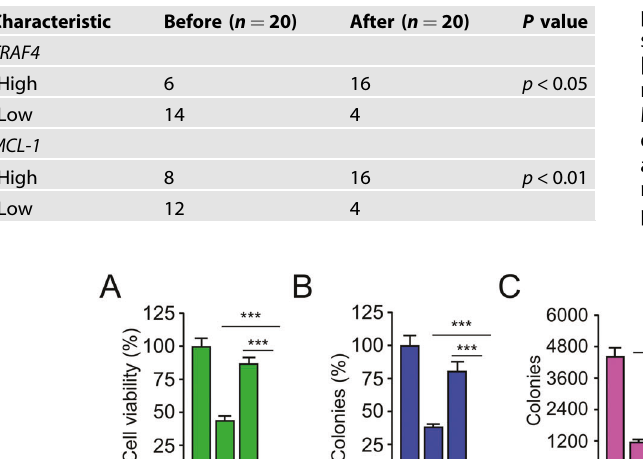
Table 2. Quanti fi cation of TRAF4 and MCL-1 protein levels in primary (before) and relapsed (after) OSCC